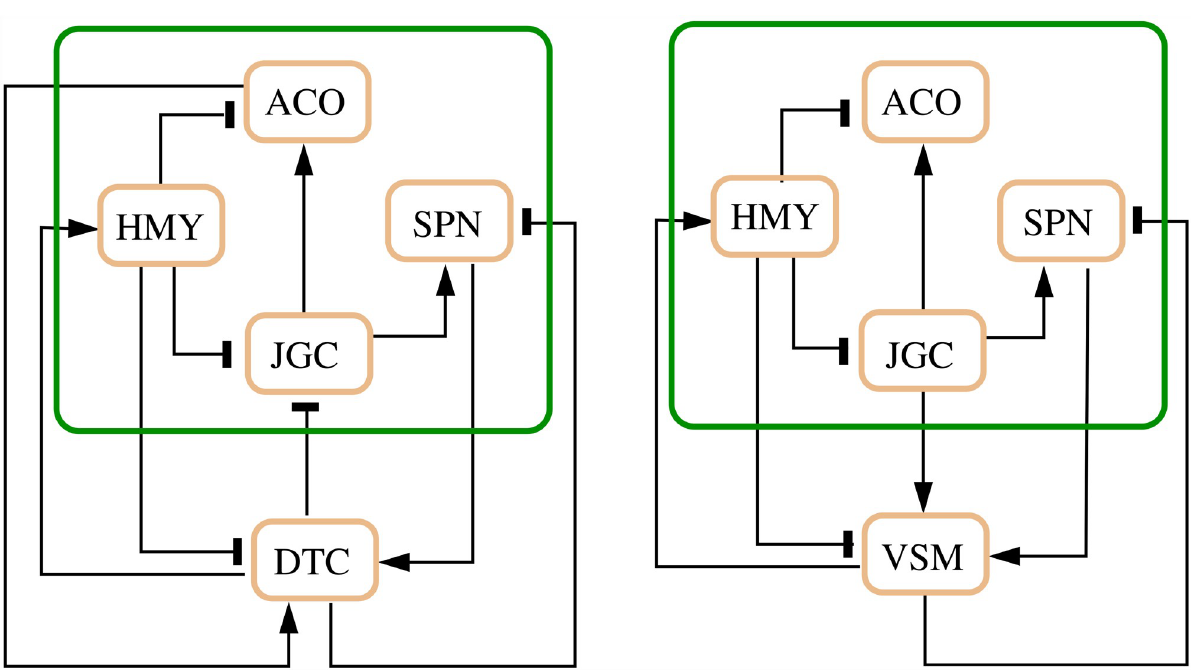
Fig 2. The two coexisting feedback schemes: The Renal Distal Tubule and Collecting Duct regulation (left) and the Vascular Smooth Muscle regulation (right).